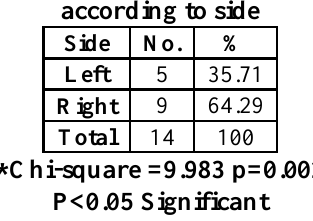
Table 4: Distribution of MRMC canals